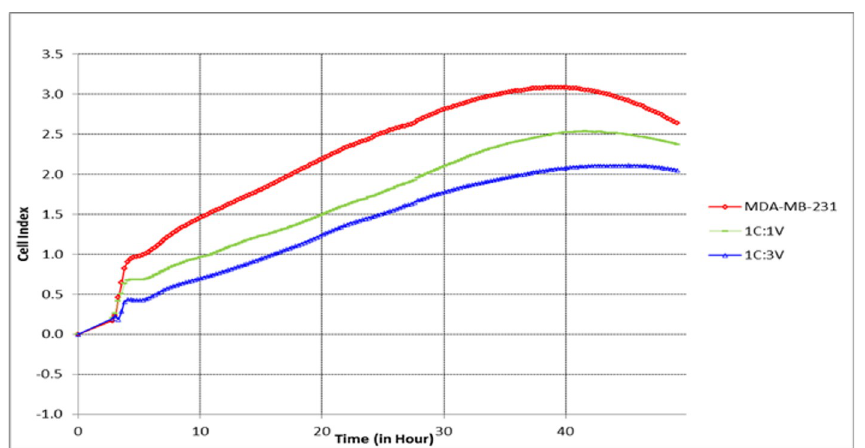
Fig 3. The effect of CVMSCs on MDA-MB231 proliferation. The effect of CVMSCs on MDA-MB231 cells proliferation was assessed in vitro over 50 hour. C is MDA-MB231, and V is CVMSC. MDA-MB231 cells were pretreated with CVMSCs through a transwell membrane. The reduction in the proliferative capacity of MDA-MB231 induced by CVMSCs was statistically significant ( P < 0 . 0001) compared to the control; untreated MDA-MB231). Each experiment was done in quadruplicate.